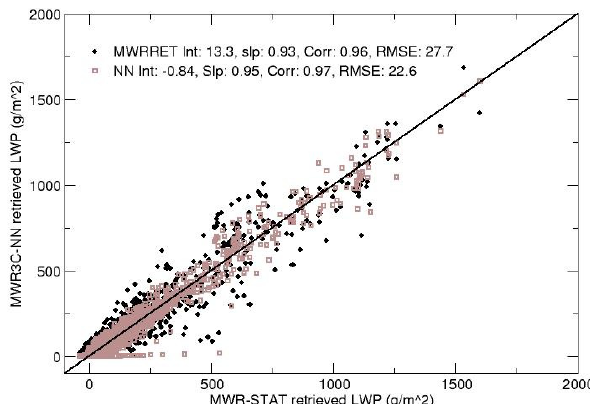
Fig. 12. In the x axis is the LWP retrieved with a linear statistical retrieval from the 2-channel radiometer MWR-STAT. In the y axis is the LWP retrieved from the 3-channel radiometer using a neu- ral network (MWR3C-NN, brown point) and a physical retrieval (MWRRET, black points). Data were collected at the SGP in Au- gust 2012, N = 39